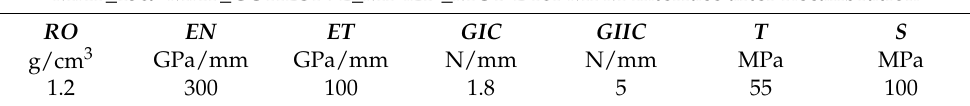
Table 4. Material card parameters for the cohesive elements with MAT_138 in the simulation model in LS-DYNA representing the MPM interface after